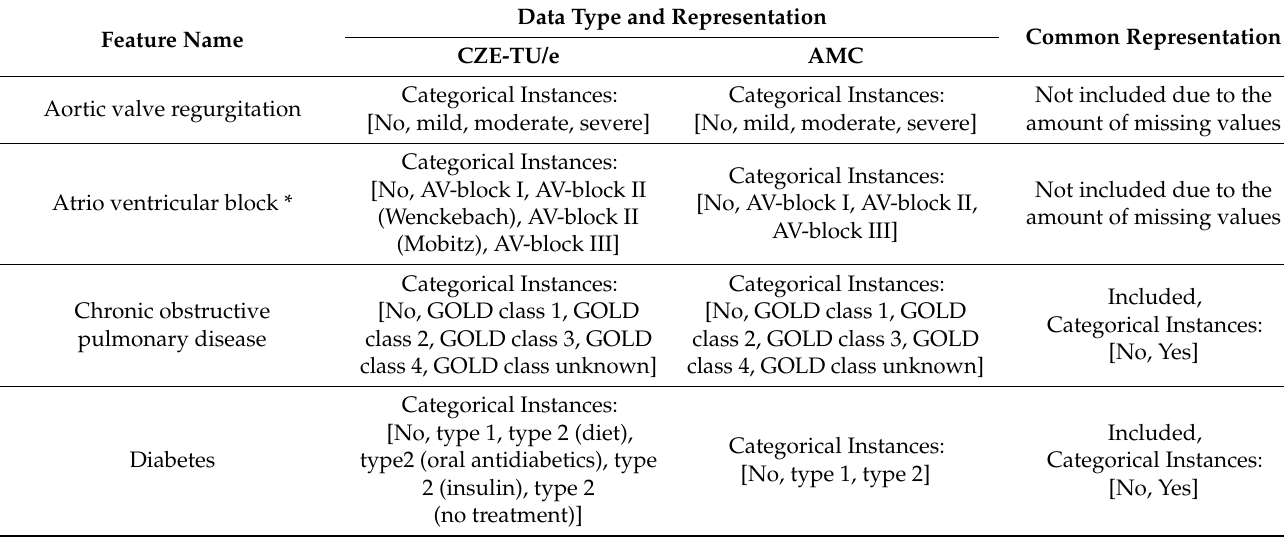
Table A2. Clinical data harmonization stage. Summarized feature detail and difference for the two centers: Amsterdam UMC (AMC) and Catharina hospital of Eindhoven